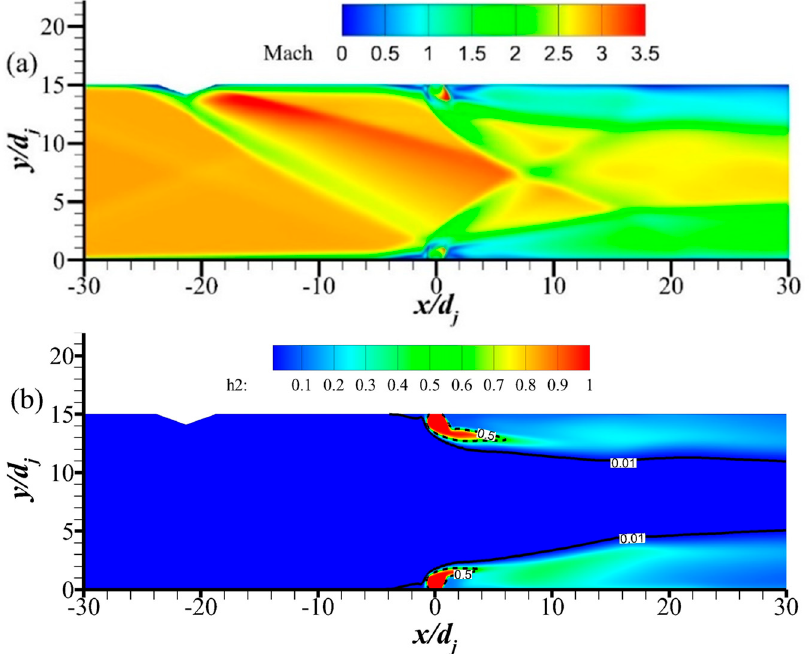
Figure 8. Flow field structure diagram of Case3. ( a ) Mach number contour. ( b ) Hydrogen mass fraction contour and contour line.